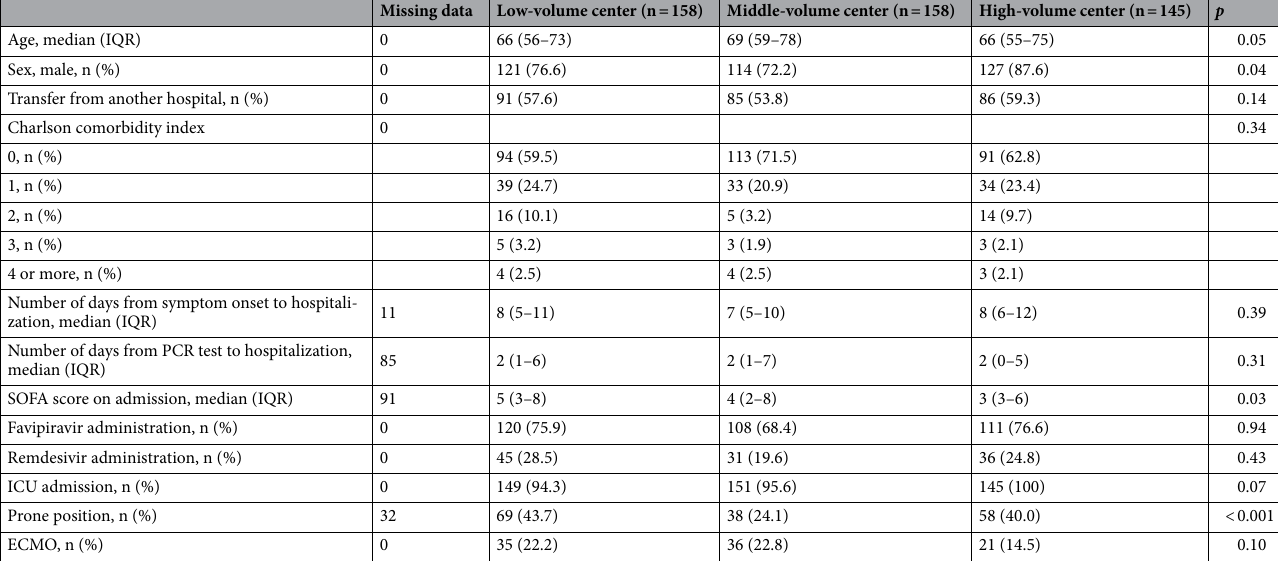
Table 2. Characteristics of the study population. IQR interquartile range, PCR positive polymerase chain, SOFA sequential organ failure assessment, ICU intensive care unit, ECMO extracorporeal membrane oxygenation.